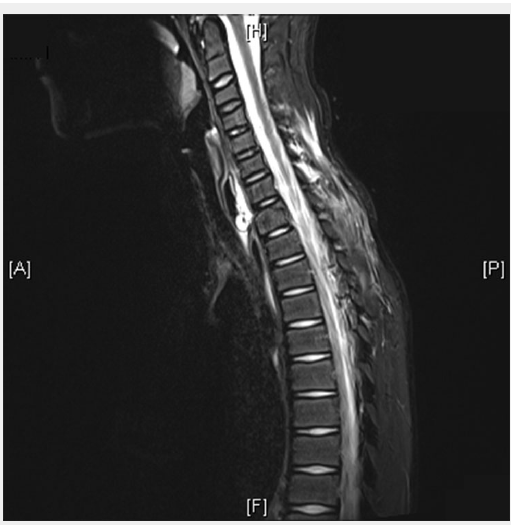
11.5-year-old boy with a T1 compression fracture after a fall (hyperflexion mechanism) with his bike ( A ). Segmental kyphosis may be underestimated on a CT scan ( B ) in supine position. He presented with neck pain, without neurologic compromise but with difficulties to swallow due to a prevertebral haematoma as visible on the MRI ( C ). 3 months in a halo followed by 4 weeks in a supportive collar led to full